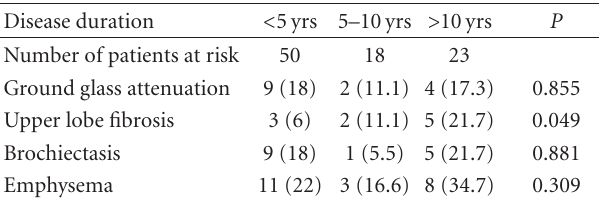
Table 2: Prevalence of thoracic HRCT abnormalities in patients with AS according to disease